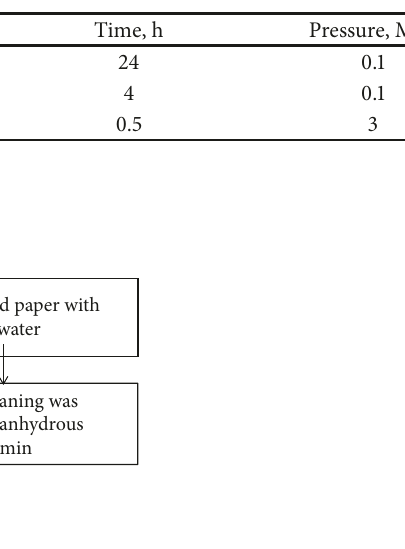
Table 1: Preparation parameters for three kinds of LDH conversion coatings.